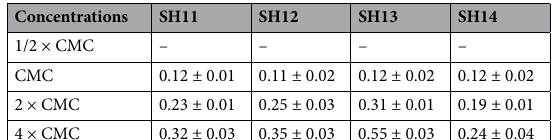
Table 3. The zone of inhibition diameters (cm) of the studied soil bacteria by the surfactant produced by the SHA302